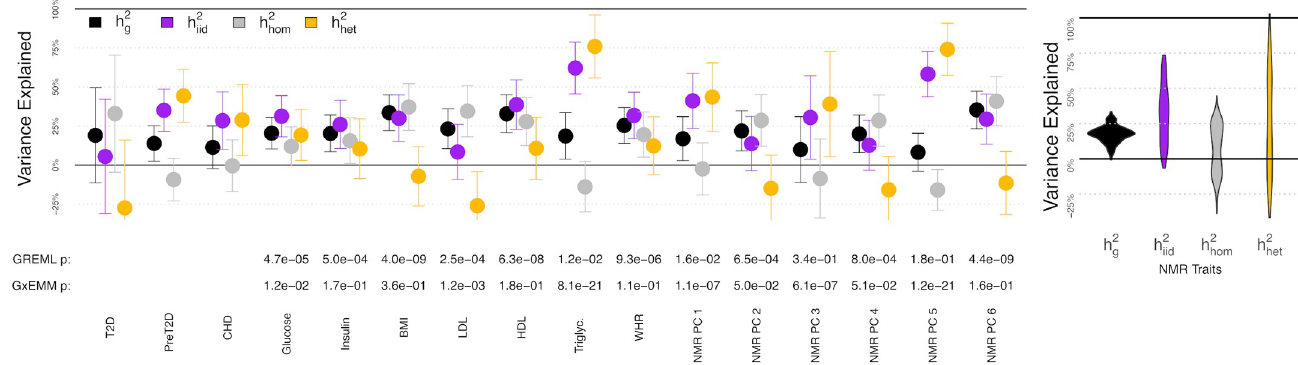
Fig 5. Polygenic heterogeneity in the inferred metabolic subtypes. Left: Point estimates ± 2 s.e. for traits used in MFMR clustering. Right: Across-trait estimate distribution for all 228 raw NMR traits. h 2 heritability estimates from IID GxEMM, and h 2